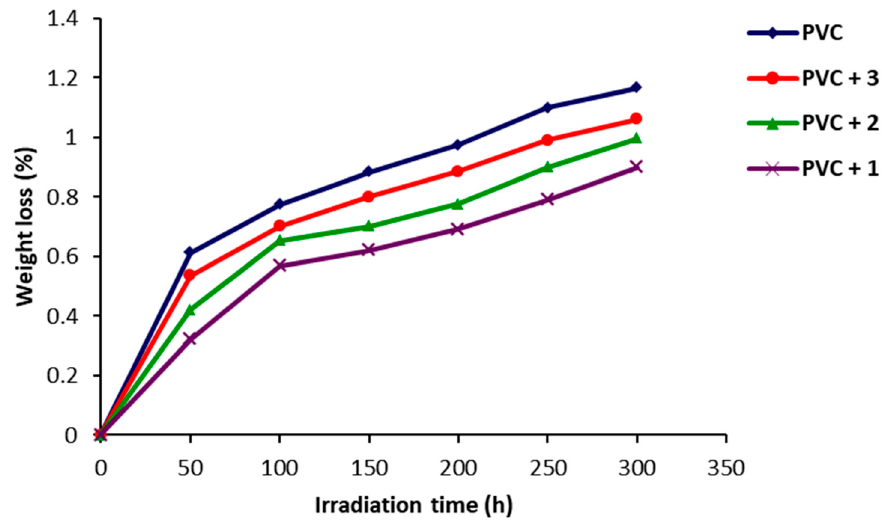
Figure 6. Effect of irradiation of PVC films on weight loss (%).